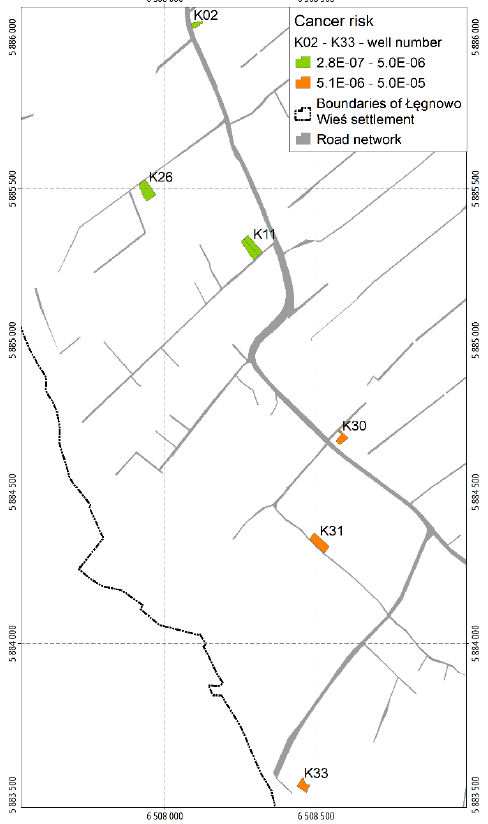
Figure 7. Map of total cancer risks in